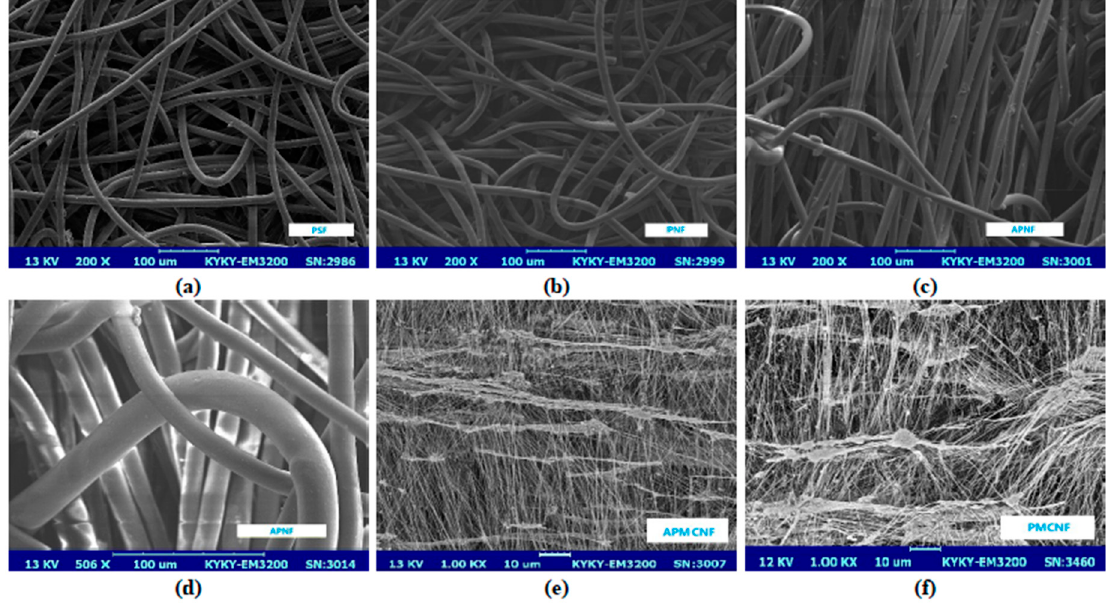
Figure 1. SEM micrographs of the filter surfaces: ( a ) PSF, ( b ) PNF, ( c ) APNF, ( d ) APNF (Fibers of different diameters), ( e ) APMCNF, ( f ) PMCNF.